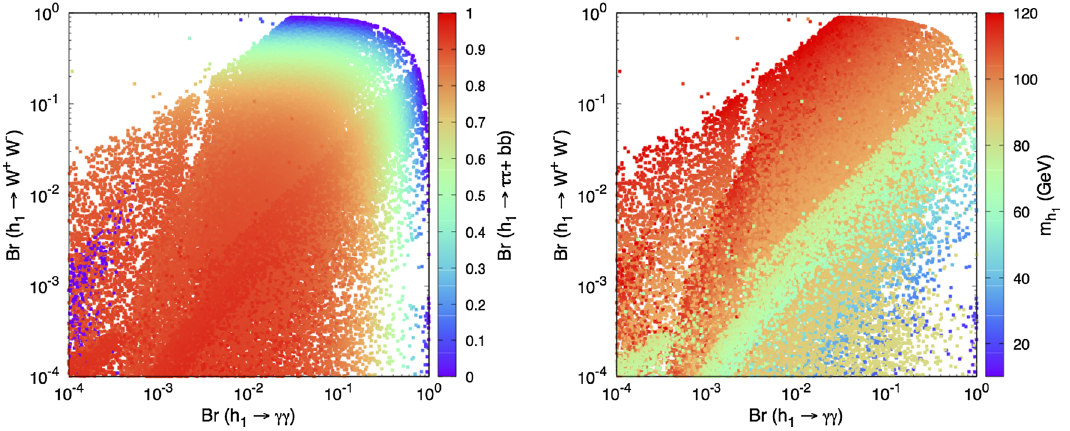
Fig. 2 Br ( h 1 → W + W − ) and Br ( h 1 → γγ) vs. Br ( h 1 → bb ,τ + τ − ) (left), and m h